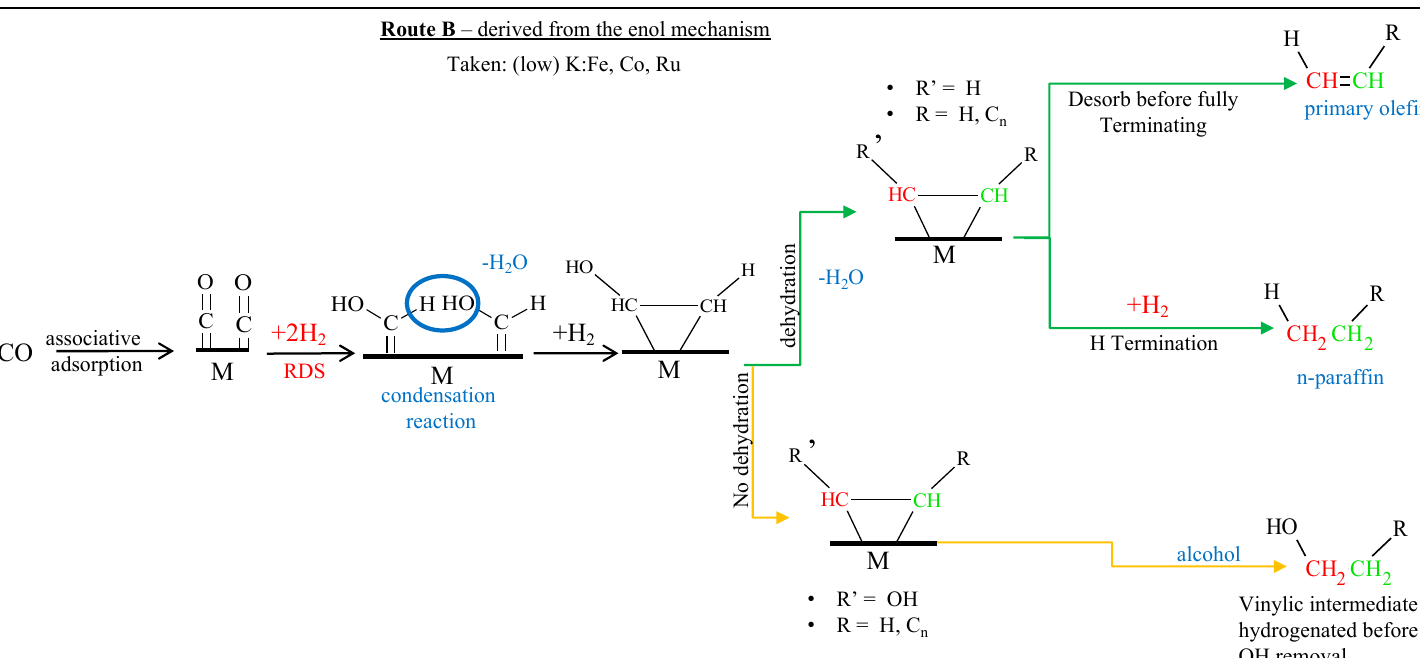
Figure 43. Proposed route B for the formation of several products observed in FTS, based on the enol mechanism. While the product distribution for primary versus secondary products is still under debate [20,22,24,46,47,52,53,98,110–120,122,132,133], the findings from